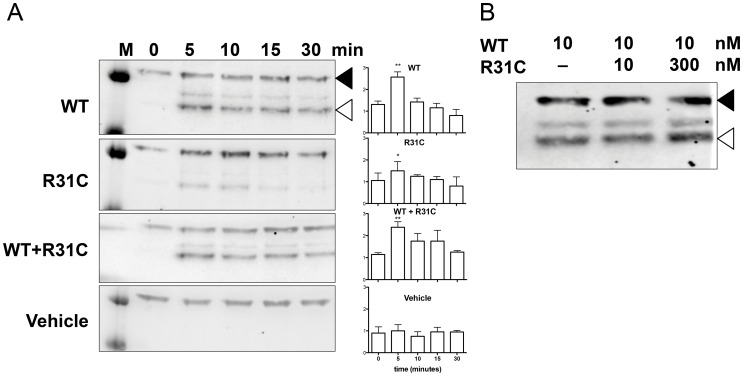
ERK1/2 phosphorylation by Western blot.(A) LbetaT2 cells were starved overnight in serum-free DMEM and then treated by 10 nM WT, 10 nM R31C, 10 nM WT +10 nM R31C peptides or vehicle for 0, 5, 10 and 30 minutes. Representative of four experiments. Density quantification is displayed on right-hand, and data are expressed as mean ± SD for four experiments. *p<0.05; **p<0.01 over baseline. (B) LbetaT2 cells were starved overnight in serum-free DMEM and then treated by a constant dose of WT GnRH (10 nM) and increasing (0–10–300 nM) doses of mutant R31C peptide after 5 minutes exposition. Lysates were analyzed by Western Blotting using phospho-ERK1/2 antibodies (Cell Signaling®, open arrow) and mouse monoclonal anti alpha-tubulin (Sigma Aldrich®, St. Louis, MO, close arrow). Similar results on ERK intensity and kinetics were obtained using transiently transfected HEK293T cells.